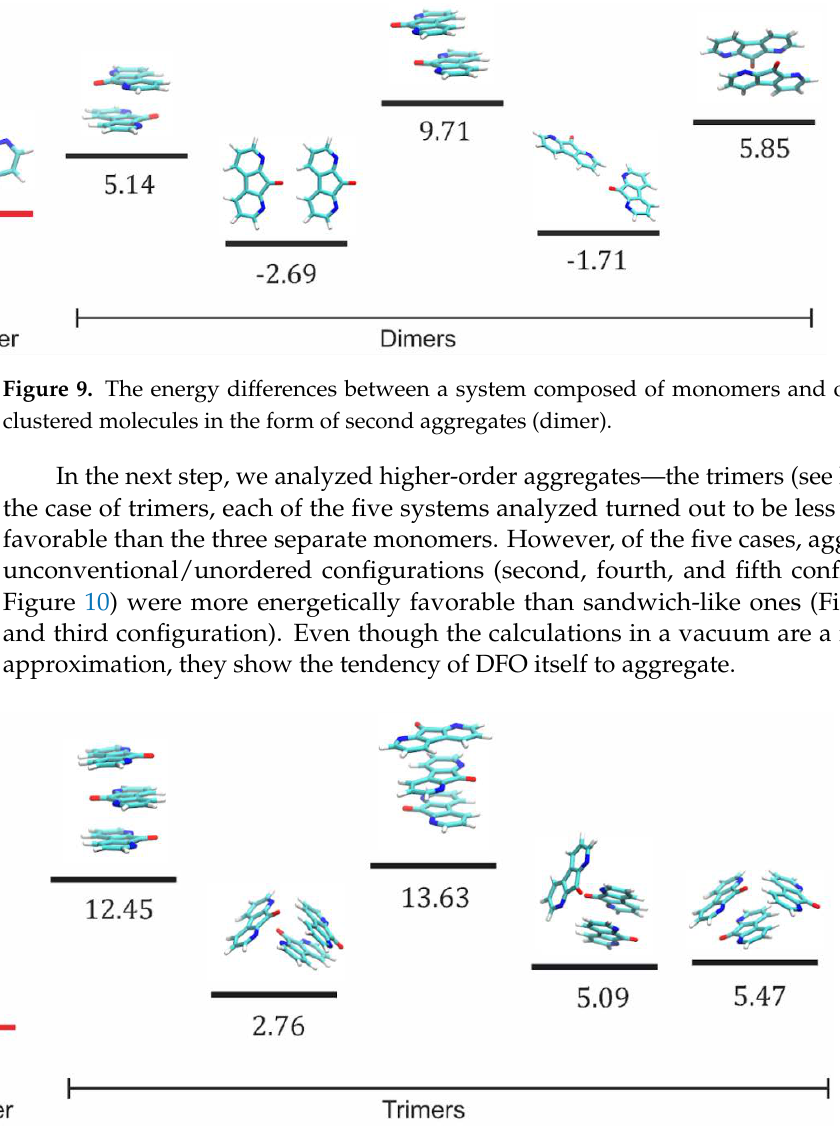
Figure 10. The energy differences between a system composed of monomers and one containing clustered molecules in the form of third-order aggregates (trimer).